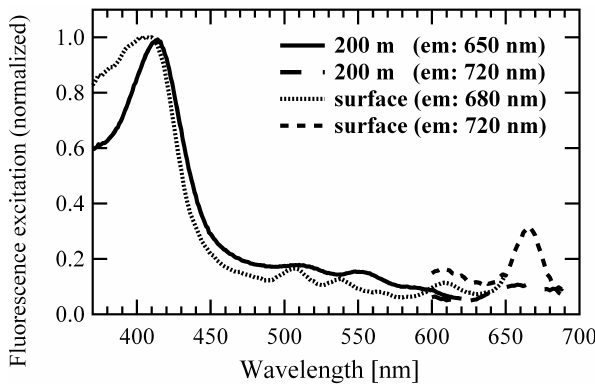
Fig. 9. Single fluorescence excitation spectra from the same two samples as in Fig. 8. The specific emission wavelengths used for the measurements are shown in the legend.